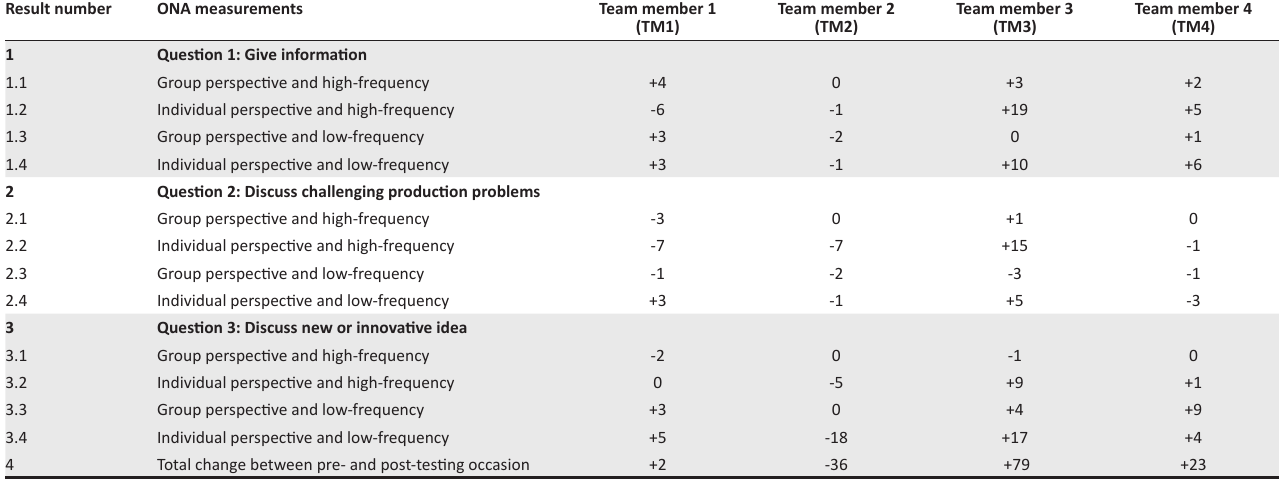
TABLE 4: Change in number of overall relationship ties after coaching per team member. Result